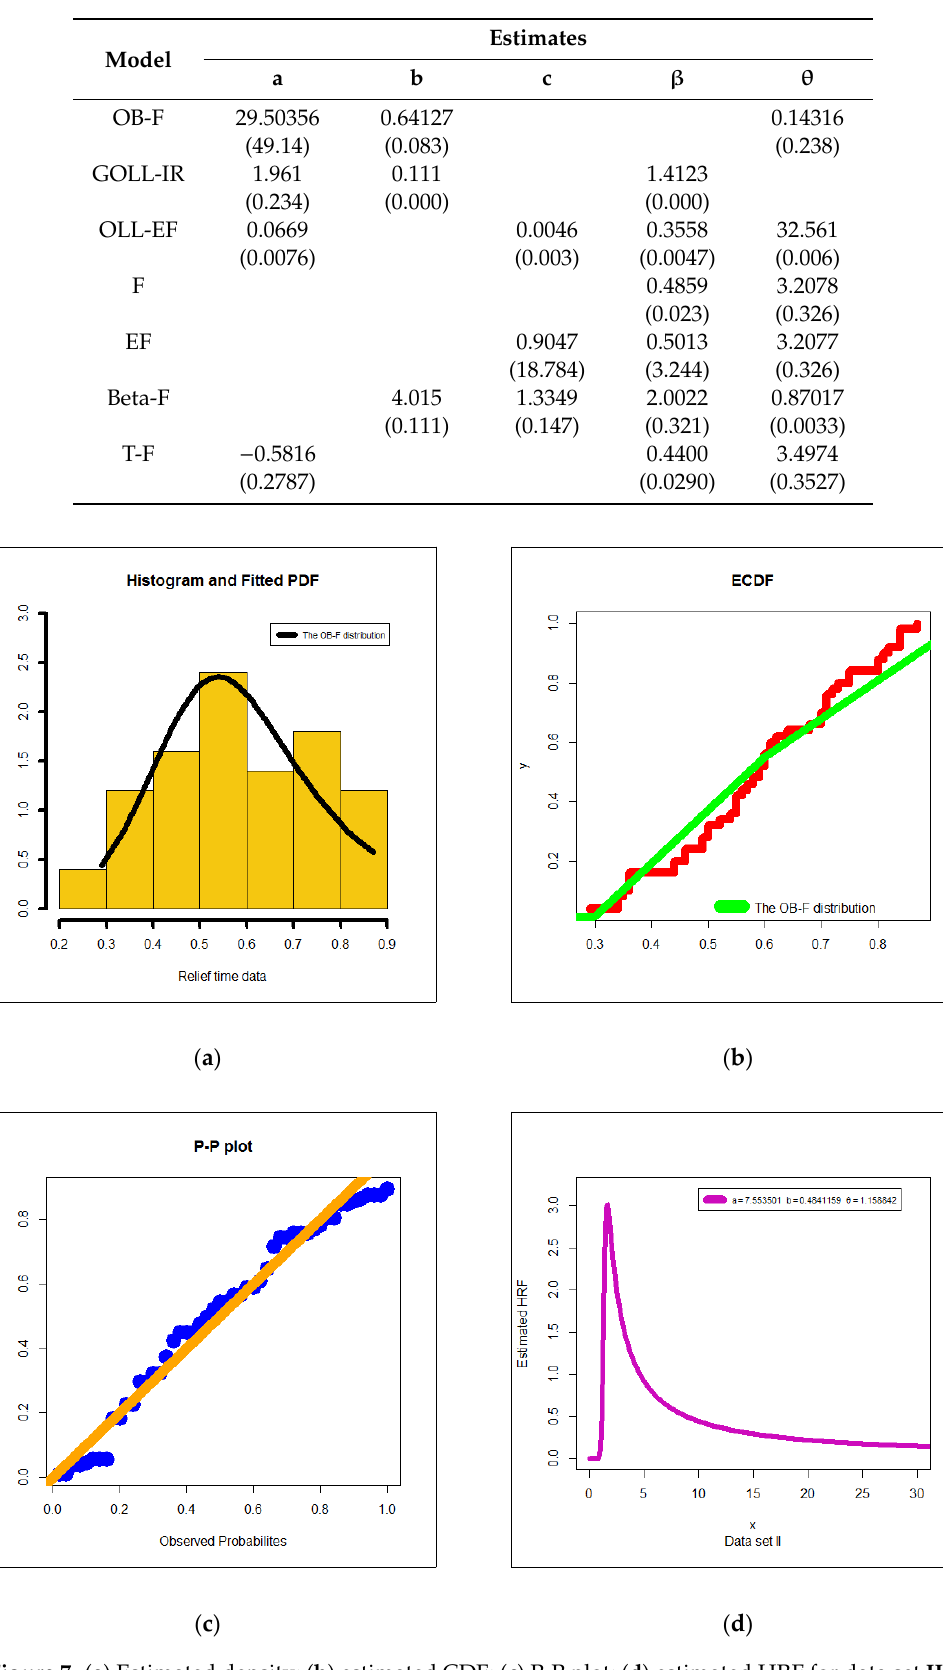
Table 12. MLEs and their standard errors (in parentheses) for data set III.